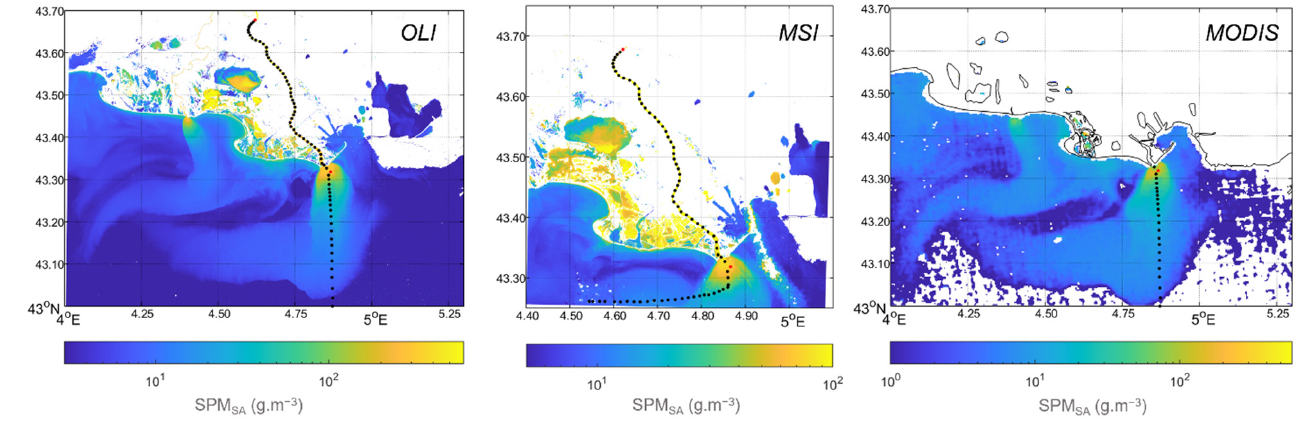
Figure A5. SPM concentration maps with the location of the transect points used in the study for OLI, MSI, and MODIS. The red points correspond to the SORA and MesuRho transect points. For MSI, the tiles end just after the Rhône River mouth; the transect is thus deviated towards the west in order to follow a smooth SPM concentration decrease as much as possible.